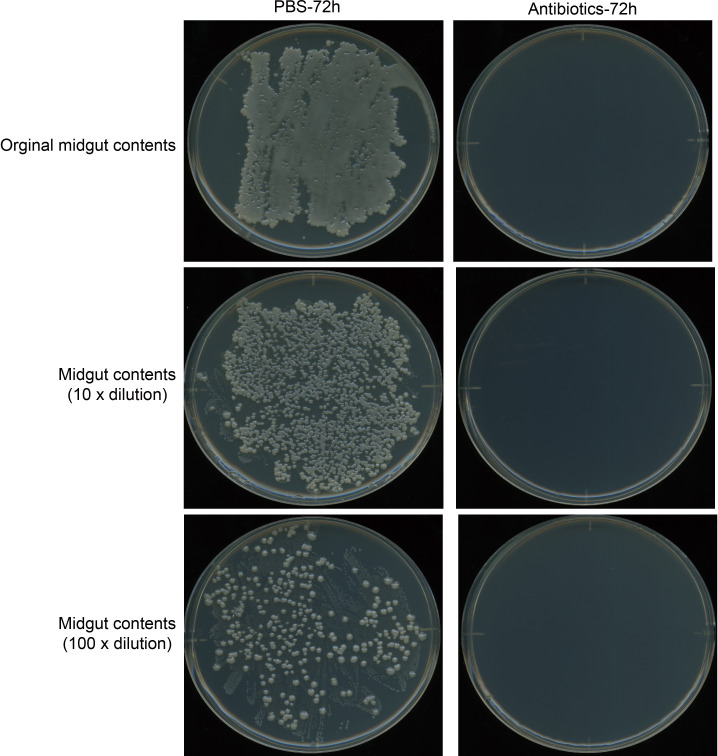
The midgut microbiota is completely killed by the antibiotic cocktail.Multiple replicates were carried out with the same concentrations of antibiotics added to forage to feed P. xylostella larvae, with similar results. The antibiotic cocktail contains 100 kU/mL penicillin, 100 mg/mL streptomycin, and 50 mg/mL gentamycin.